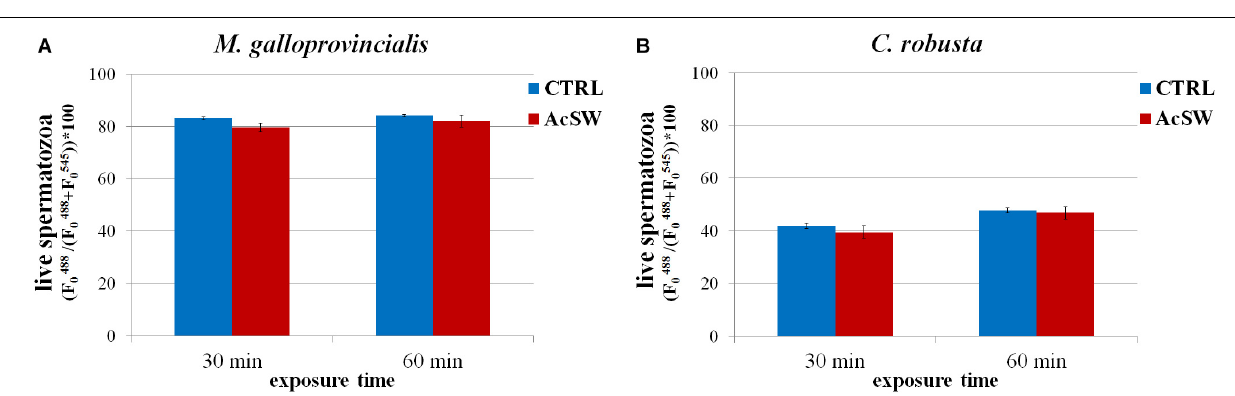
FIGURE 6 | Effects of acidified seawater (AcSW) on sperm viability in M. galloprovincialis (A) and C. robusta (B) (mean ± SE). Viability was determined after exposure for 30 and 60 min to filtered natural seawater with a natural pH value of 8.1 (CTRL) and to AcSW with a pH vale of